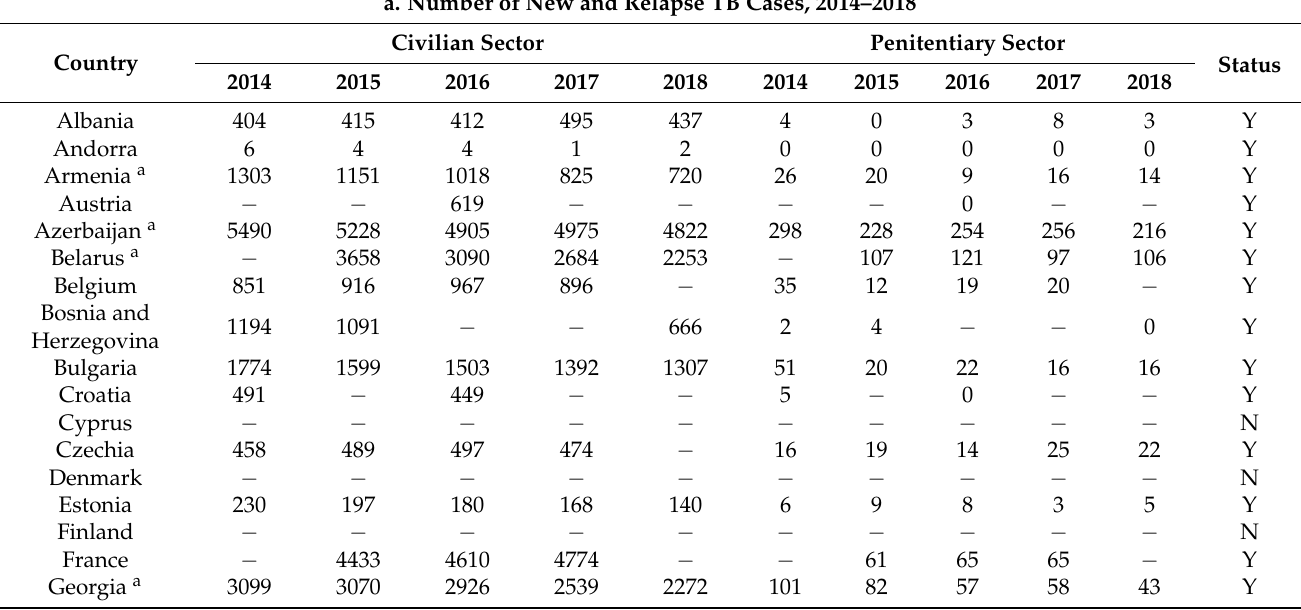
Table 1. Completeness of TB reporting for civilian and penitentiary sectors via The WHO global TB data collection system, WHO European Region